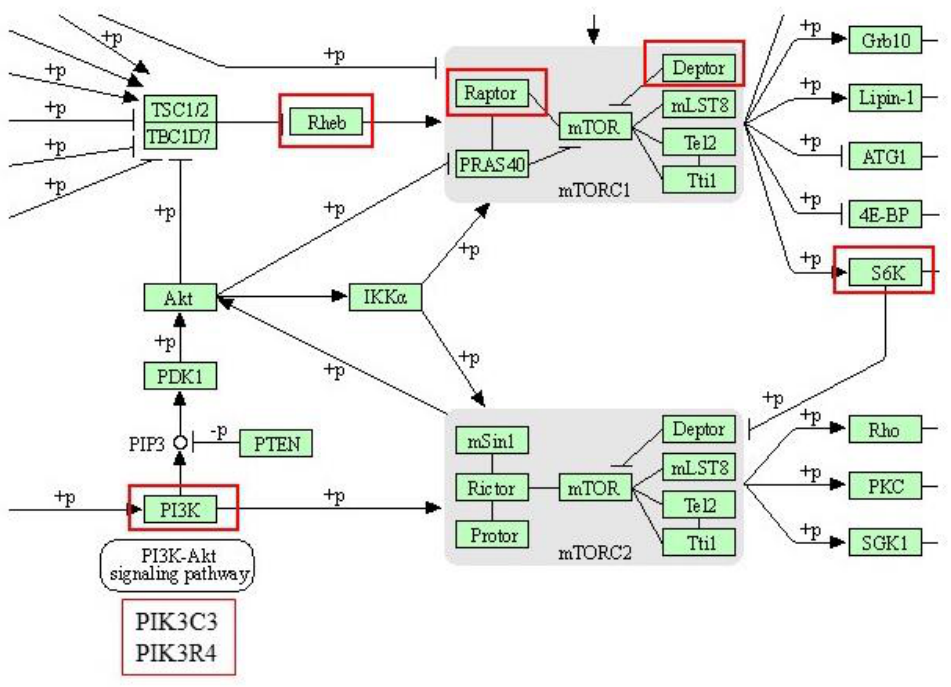
Figure 7. KEGG diagram for the mTOR pathway (hsa04150) with the differentially abundant proteins identified in LBW animals subjected to an HFD marked by red squares.